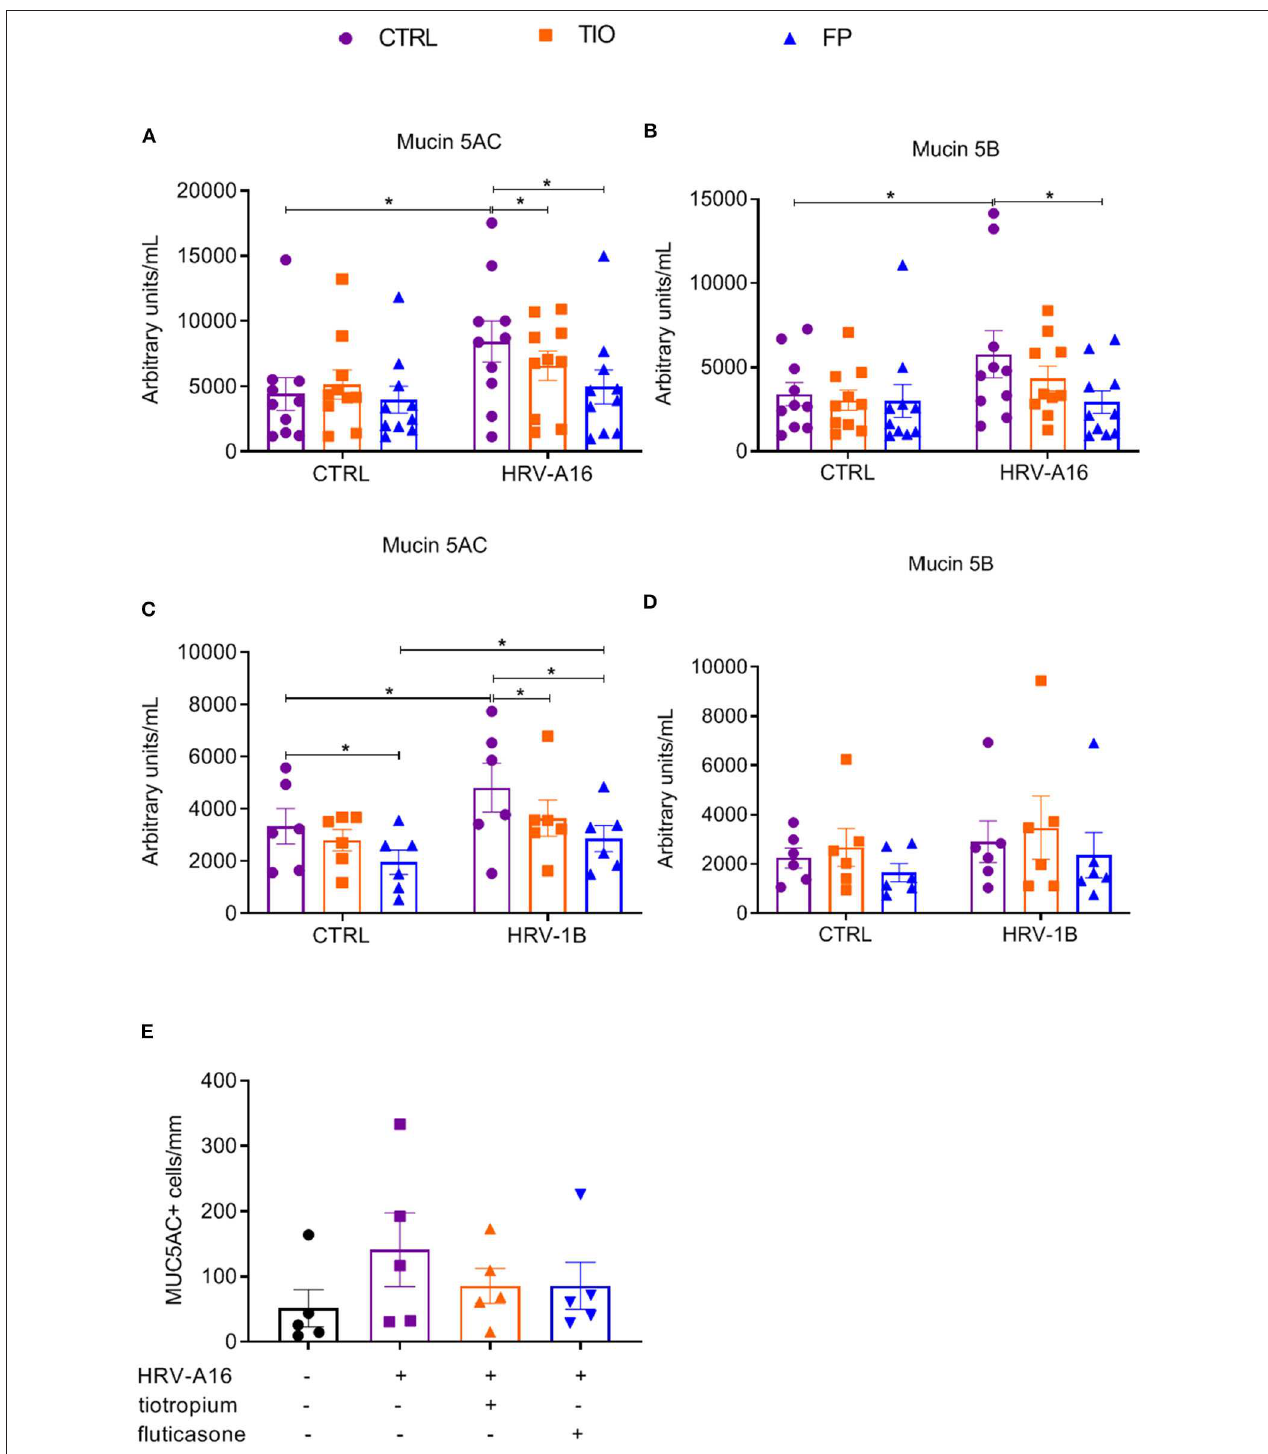
FIGURE 6 | Effects of tiotropium and fluticasone on mucin release in ALI-PBEC. ALI-PBEC were pre-treated with tiotropium or fluticasone and infected with HRV-A16 (MOI 5). Cells were harvested at 48h after infection. The protein levels of Mucin 5AC (A,C) and Mucin 5B (B,D) were measured by ELISA. n = 10 or 6 independent donors. (E) Mucin 5AC positive cells were quantified as positive cell numbers/mm (length of basal membrane, n = 4). Data are mean values ± SEM and shown as arbitrary units/mL according to standard line or MUC5AC + cells/mm. Analysis of differences was conducted by paired one-way or two-way ANOVA with a Tukey post-hoc test Significant differences are indicated by * P < 0.05 compared with control or HRV-A16 group.